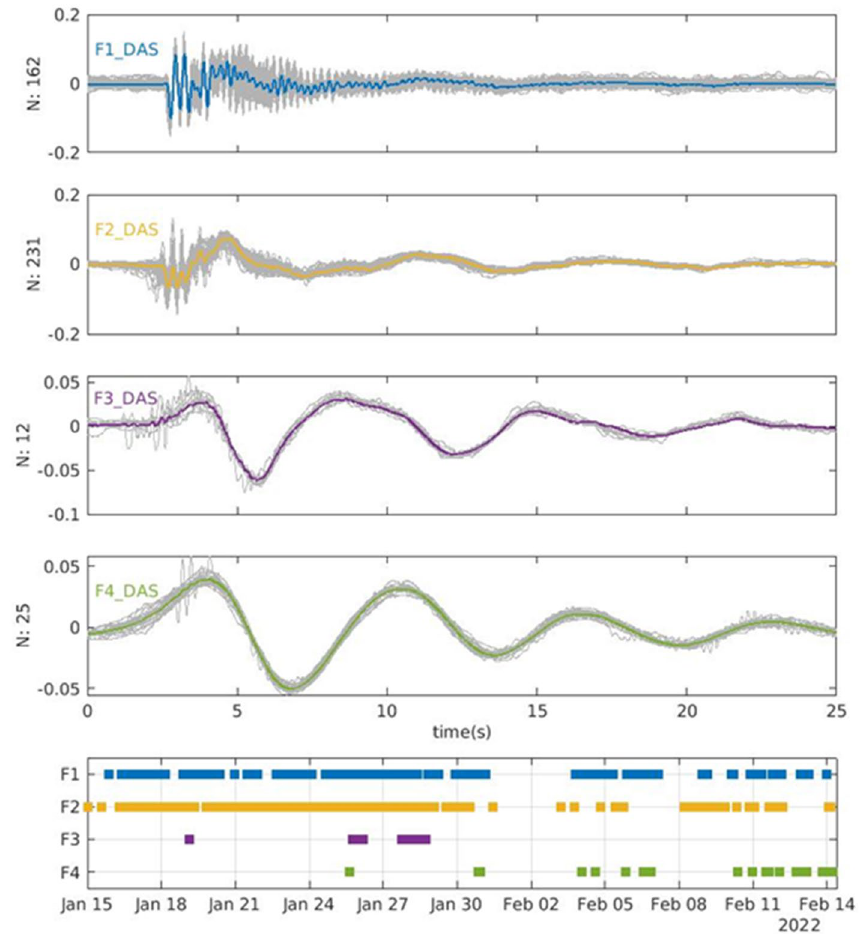
Figure 9. Stacked waveforms (thick colored lines) of individual normalized events (thin gray lines) for the identified families on the DAS data. The waveforms are those recorded at IVCR station to allow a comparison with the families identified using the seismic signal at IVCR (Fig. 6). Temporal distribution of the occurrence of the DAS classified